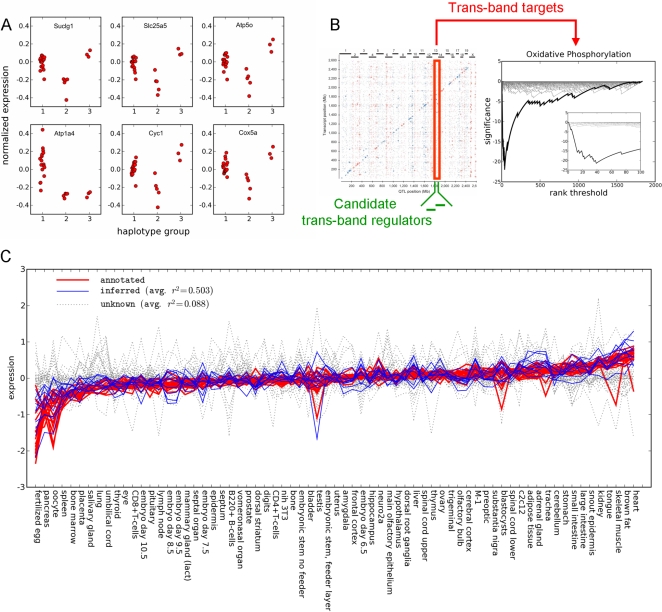
A trans-eQTL band enriched in genes in the “Oxidative Phosphorylation” pathway.(A) The expression patterns of 68 genes (“trans-band targets”) were all associated to the haplotype pattern at a region on chromosome 13 near 81.8 Mb (six strongest associations shown). Strains were assigned to haplotype groups based on local windows of genotype calls [13],[18],[19]. Each point represents the median-centered expression value on log10-scale for a given strain in the haplotype group. (B) Trans-band targets were tested for enrichment in FGS from GO, KEGG, and Ingenuity pathways database (ING). The genes in this trans-eQTL band were found to be strongly associated with the Oxidative Phosphorylation pathway, with the most significant enrichment (Se = −21.26) found among the top 40 annotated eQTL associations. For comparison, 100 random permutations of the eQTL association scores showed a maximum enrichment score of −4.13. Visualization of the enrichment analysis is shown as described in [39]. (C) Expression profiles in the Gene Atlas data set are strongly correlated for the 19 genes (red) which are annotated as being involved in the Oxidative Phosphorylation pathway (“eQTL/FGS genes”). In addition, 10 genes (blue, “inferred”) were also highly correlated which were not annotated in this pathway, but whose role in oxidative phosphorylation could be inferred. The remaining 39 genes (gray, “unknown”) in the trans-eQTL band do not share a correlated expression pattern in the Gene Atlas data set. Tissues are sorted from lowest to highest average expression according to 19 eQTL/FGS genes (red). All expression values have been median-centered on log10-scale. The “avg. r2” label indicates the average Pearson correlation to the genes in the eQTL/FGS group.